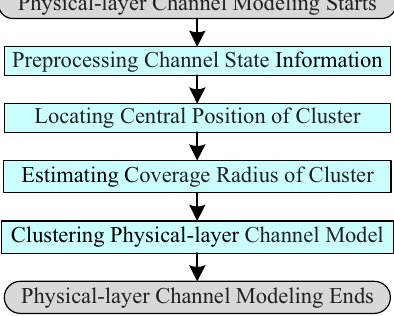
Figure 4. Process flowchart of physical-layer channel modeling.